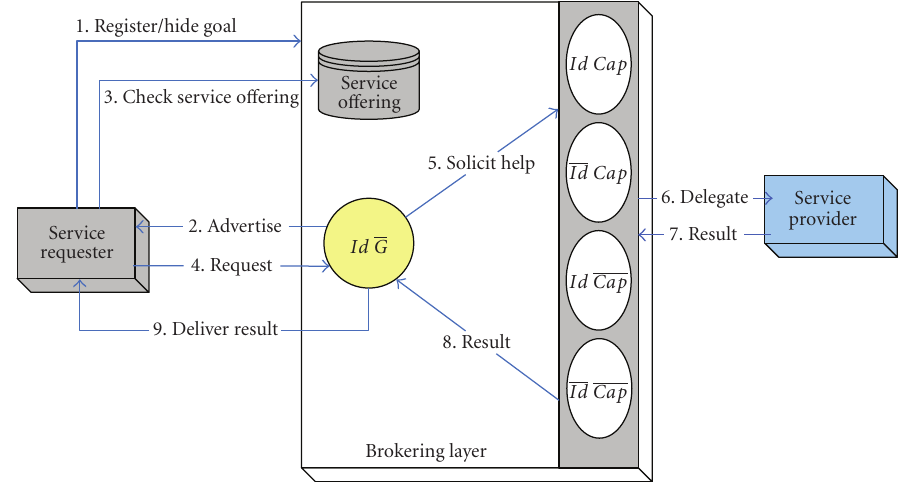
Figure 4: Interaction pattern for requesters hiding goals.